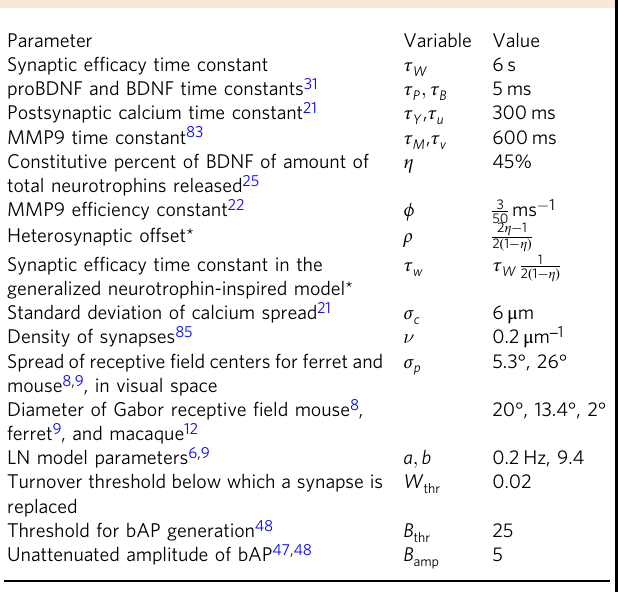
Table 1 Parameters of the proposed model along with nominal values used for simulations, unless stated otherwise.